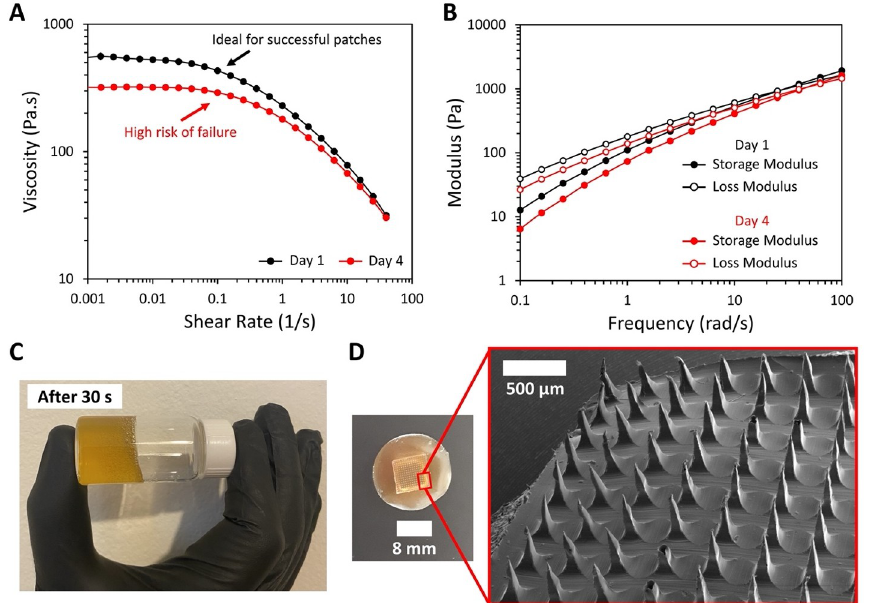
Fig 2. The study of the rheological properties of the chitosan solution confirmed that shear rate sweeps and frequency sweeps both present significant differences over time, demonstrating that reusing the solution on the fourth day results in failure patches. Rheological properties of the chitosan solution at day one and four. A) Viscosity versus shear rate sweeps, B) Storage and loss modulus versus frequency sweeps. C) Visual observation of the viscous chitosan solution on day one. D) Macroscopy picture of a microneedle patch and chitosan microneedle topography by SEM. Data refers to the average of 3 independent